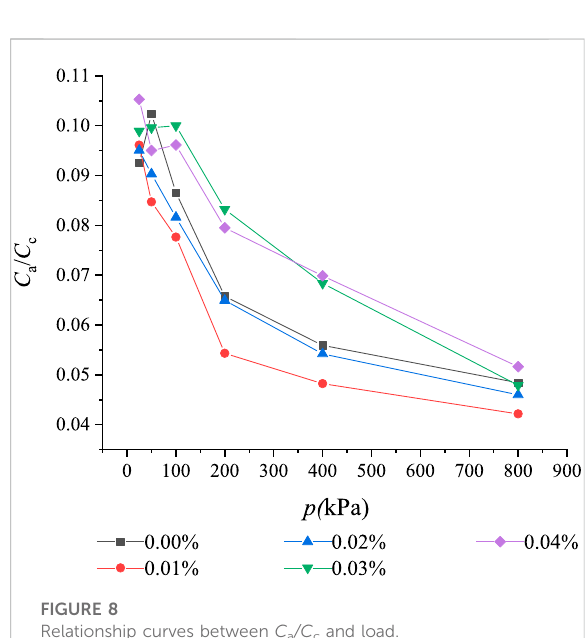
FIGURE 8 Relationship curves between C a /C c and